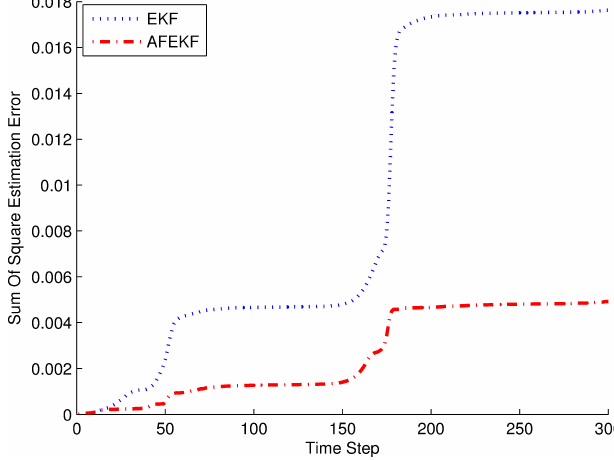
Fig. 2. Sum of the squared estimation errors (Stability conditions are met)